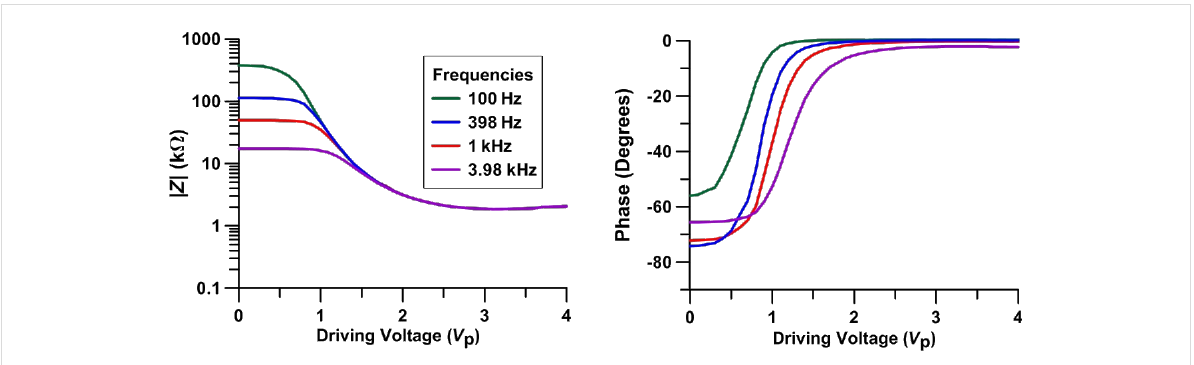
Figure 8: Impedance magnitude and phase variation at different frequencies as a function of applied driving voltage, V p . The LC is in a nematic phase.